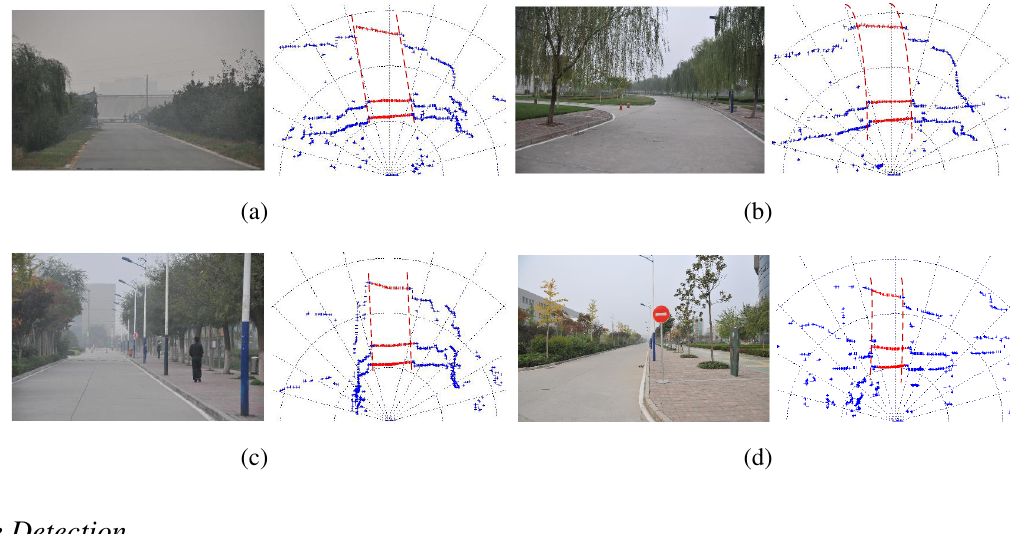
Figure 11. Some results of the road curb